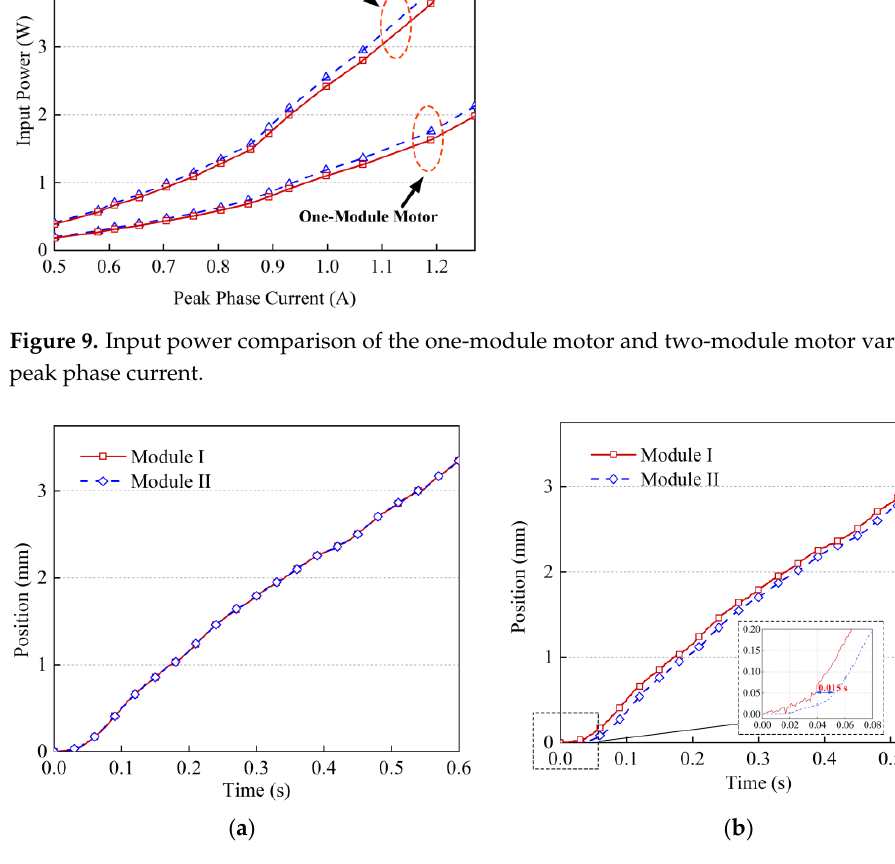
Figure 10. Position of the two-module versus time under the no external disturbance condition. ( a ) The novel method. ( b ) The conventional method.